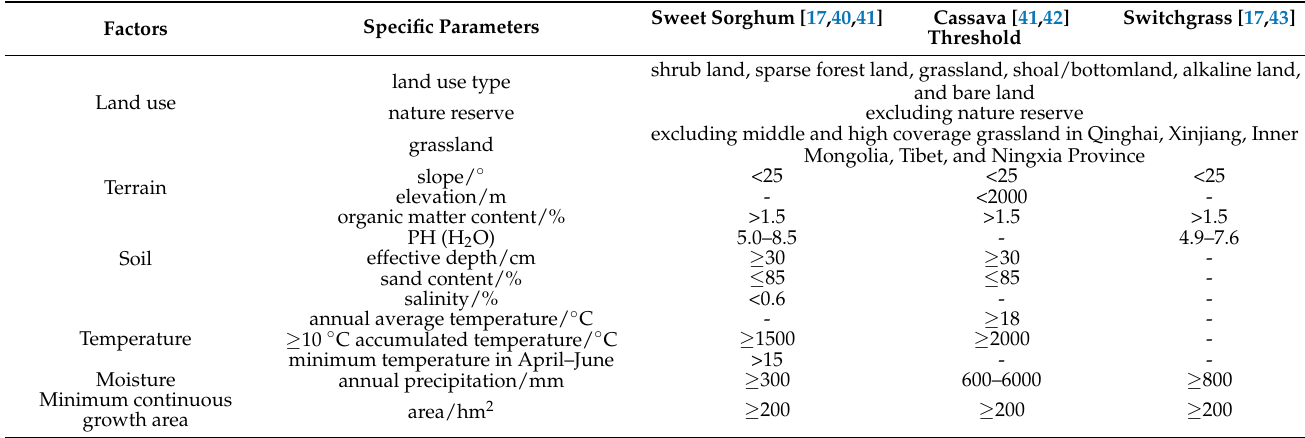
Table A2. The criteria systems of marginal land for sweet sorghum, cassava, and